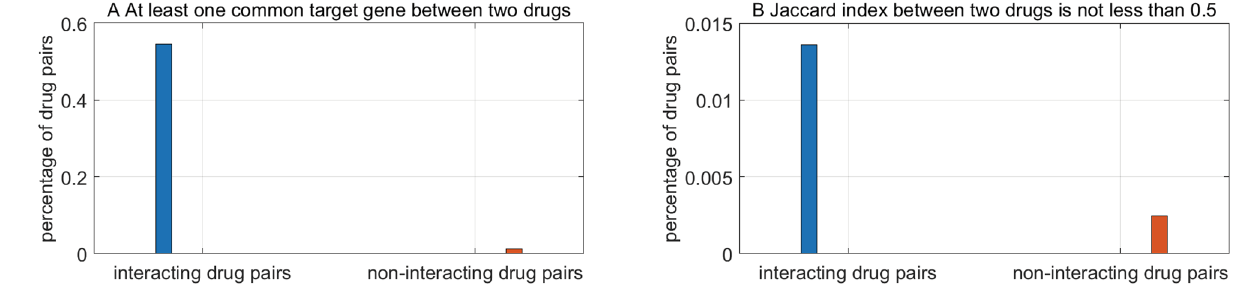
Figure 2. Statistics of common target genes between interacting and non-interacting drugs.